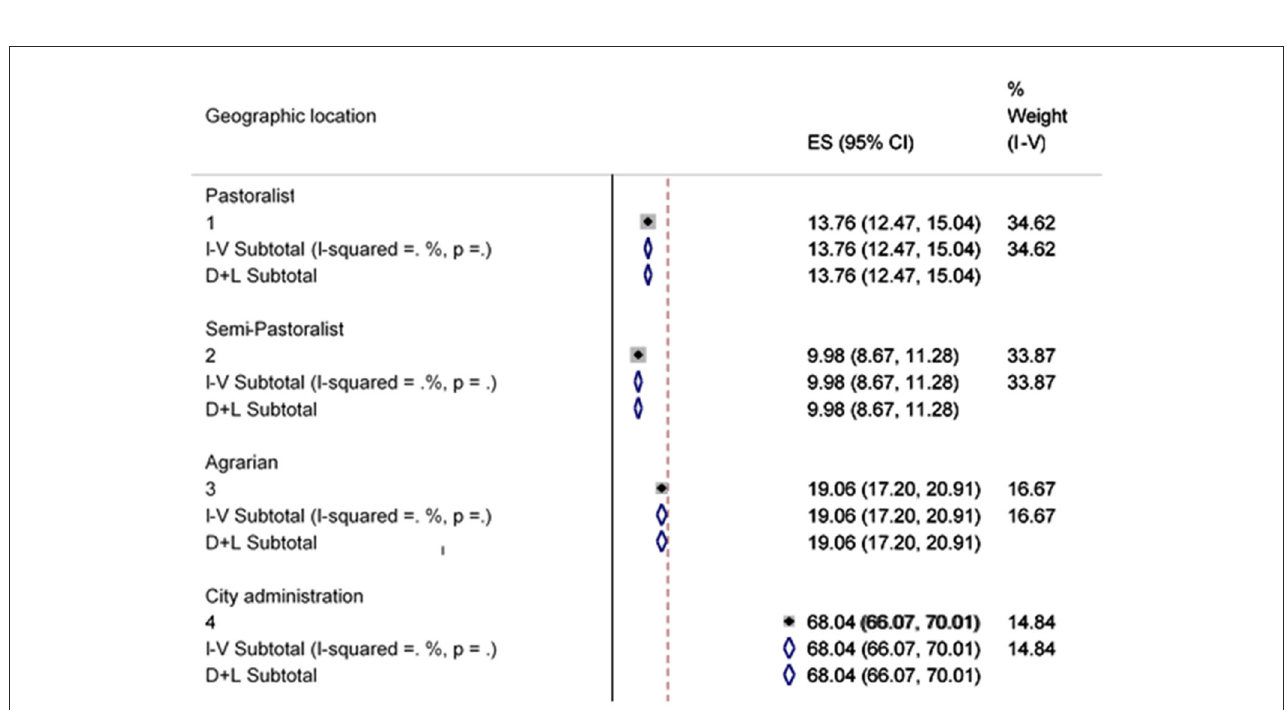
FIGURE7 Sub-group analysis of improved sanitation facility by Wealth